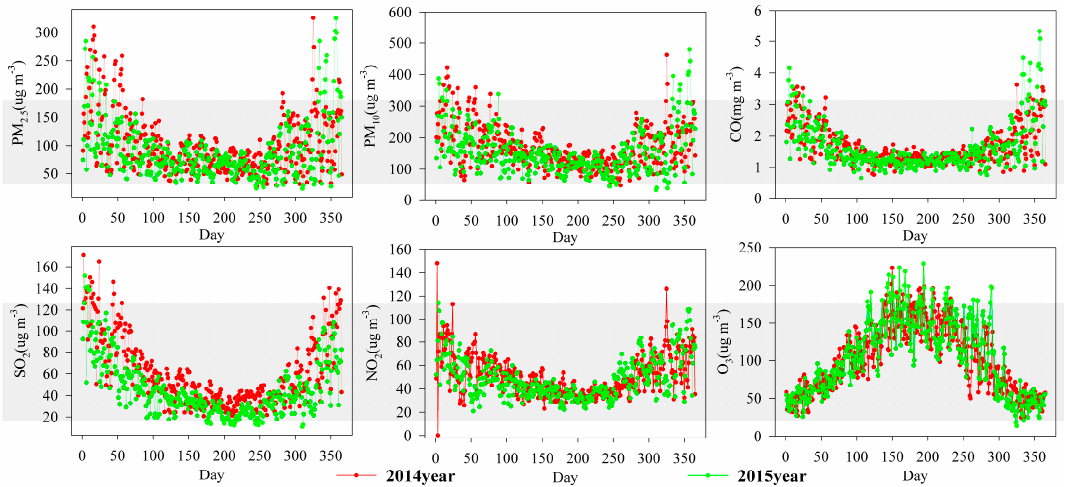
Figure 4. The daily dynamics of the principal air pollutants in the 17most polluted cities (2014 and Figure 2015).